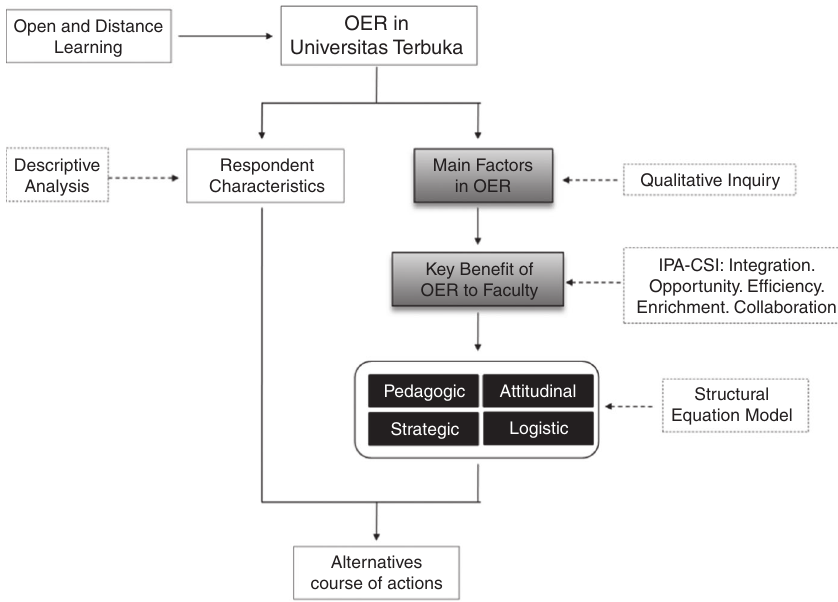
Figure 1. The conceptual